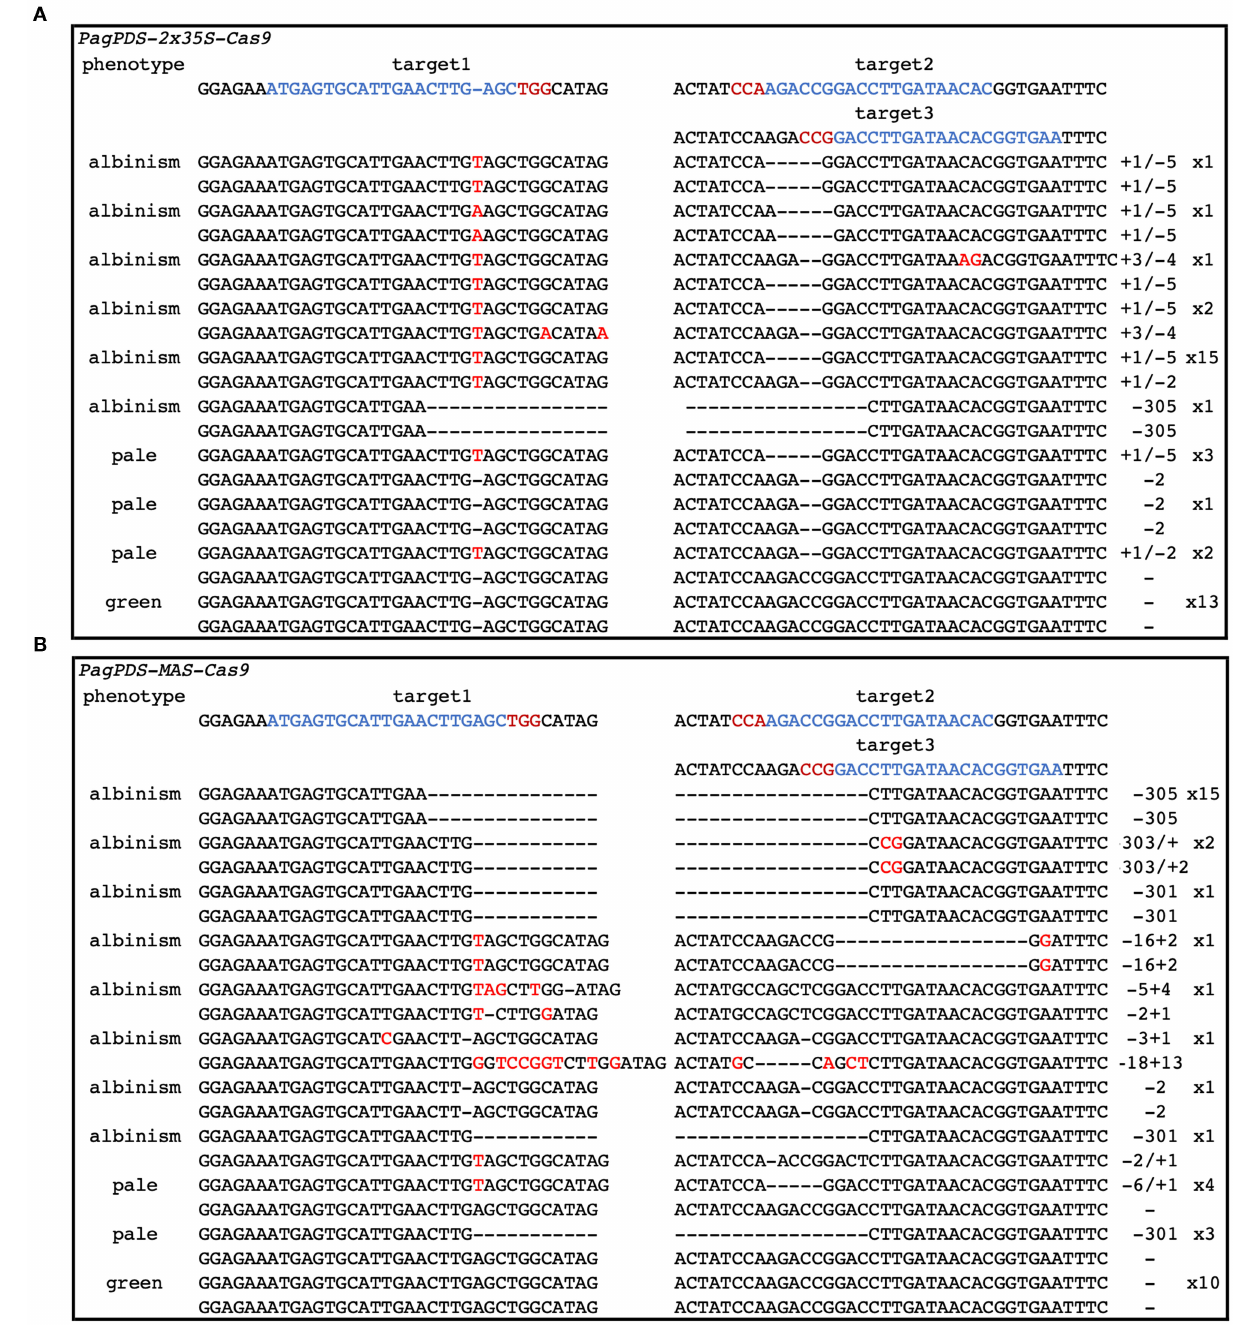
Frontiers in Plant Science |